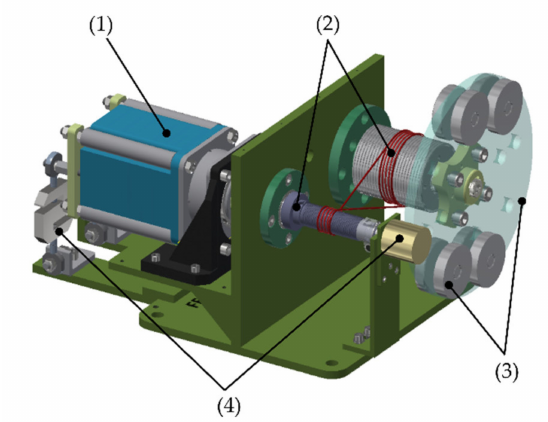
Figure 1. CAD model of the test bench: (1) power source module; (2) transmission module; (3) link module; (4) measurement